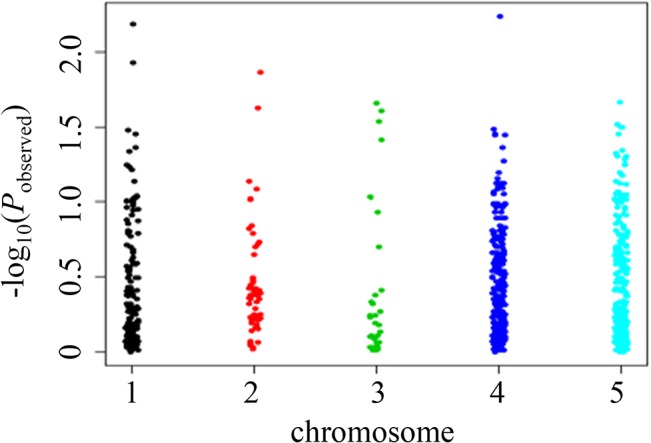
A Manhattan plot showing the associations of all SNPs.